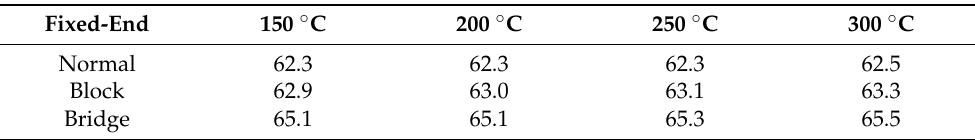
Table 3. Effective Young’s modulus of the annealed Ti/Au single layered micro-cantilevers by resonance frequency